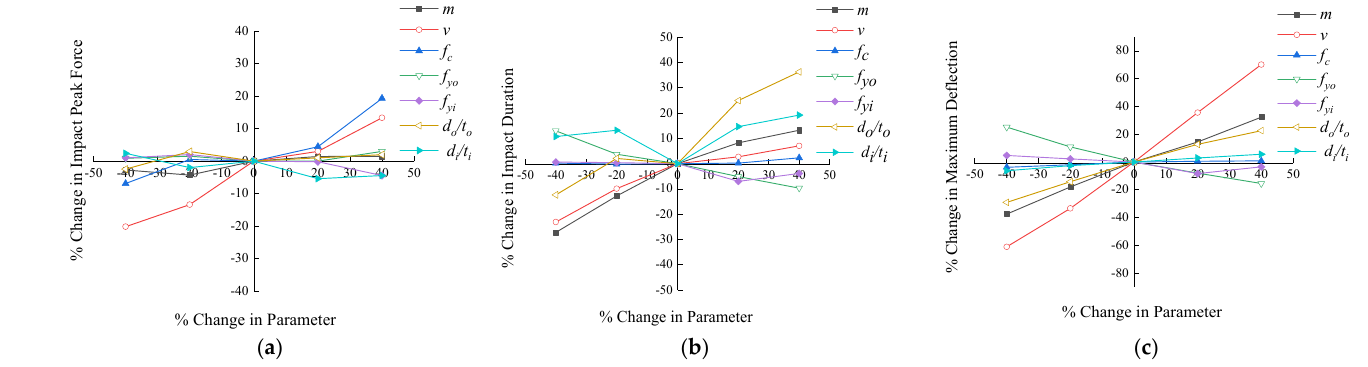
Figure 12. Sensitivity of S-DS corresponding to changes in structure-related variables. ( a ) Peak impact force; ( b ) Impact duration; ( c ) Maximum deflection.